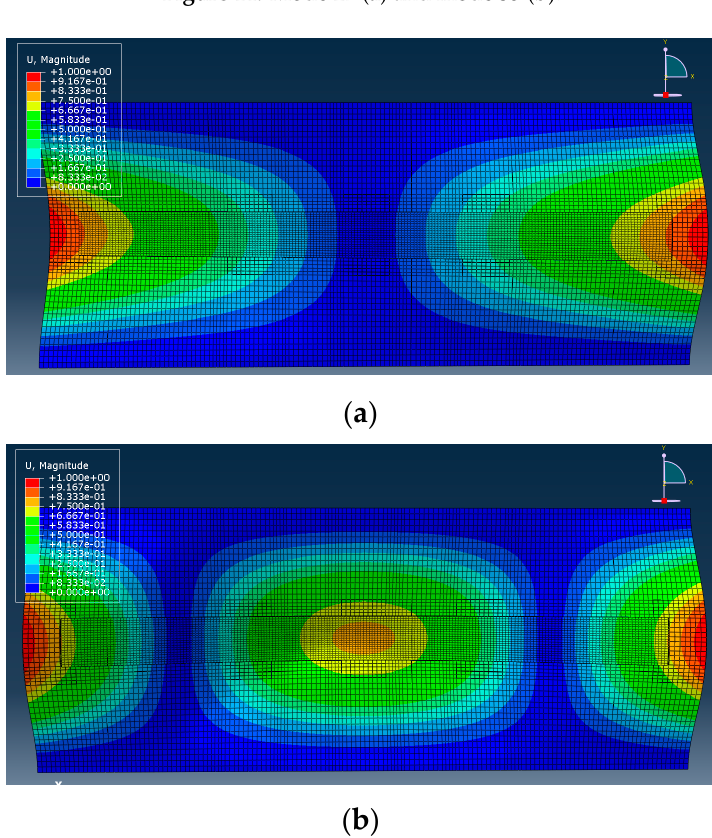
Figure 15. Mode 2 ( a ) and mode 3 ( b ).